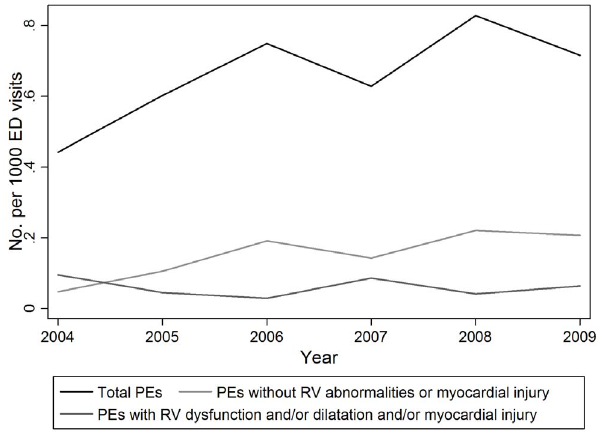
Figure 2. Annual number of PEs diagnosed by CTPA, number of PEs without associated RV abnormalities or myocardial injury, and number of PEs with associated RV dysfunction and/ or dilatation and/or myocardial